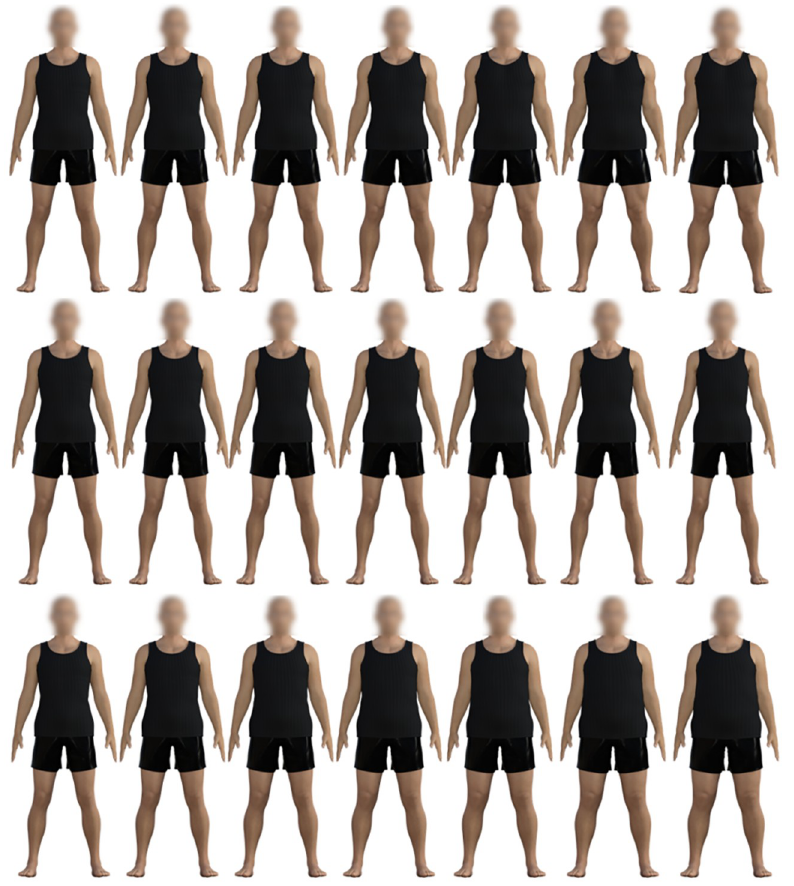
Fig 1. Illustration of the various body morphologies presented. Each of the three scales was applied to a standard body (far left) in increments of 16.67%. This resulted in 3 scales of stimuli varying in musculature (top), emaciation (middle) and portliness